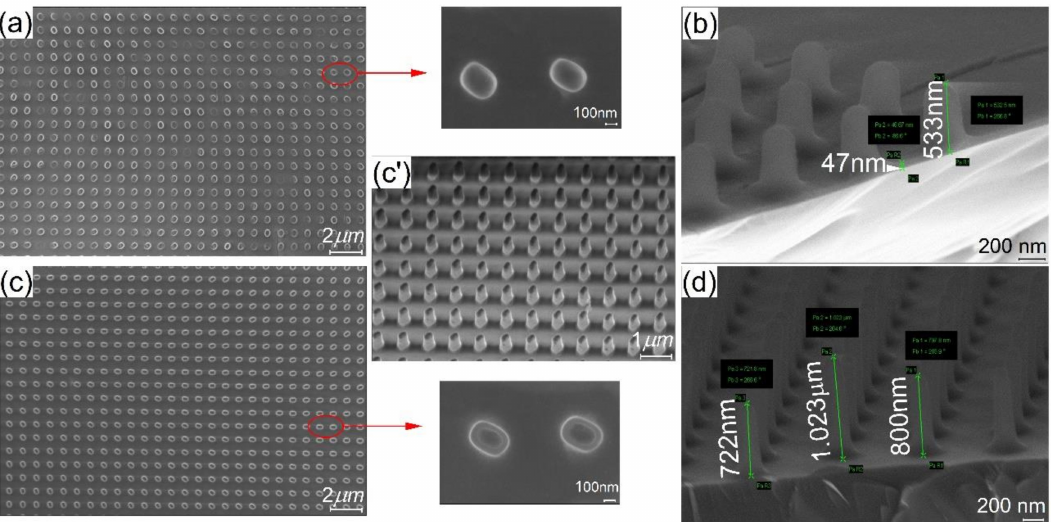
Figure 8. ( a ) Top-view SEM micrograph of the “resist metalens” imprinted at 50 mbar contact pressure and 200 nm resist thickness ( b ) side-view SEM micrograph of the “resist metalens” imprinted at 50 mbar contact pressure and 200 nm resist thickness after residual layer removal using RIE process; ( c ) top-view SEM micrographs of the “ resist metalens” imprinted at 150 mbar contact pressure and 500 nm resist thickness and ( c’ ) the respective side view; ( d ) side-view SEM micrograph after residual layer removal of the “ resist metalens” imprinted at 150 mbar contact pressure and 500 nm resist